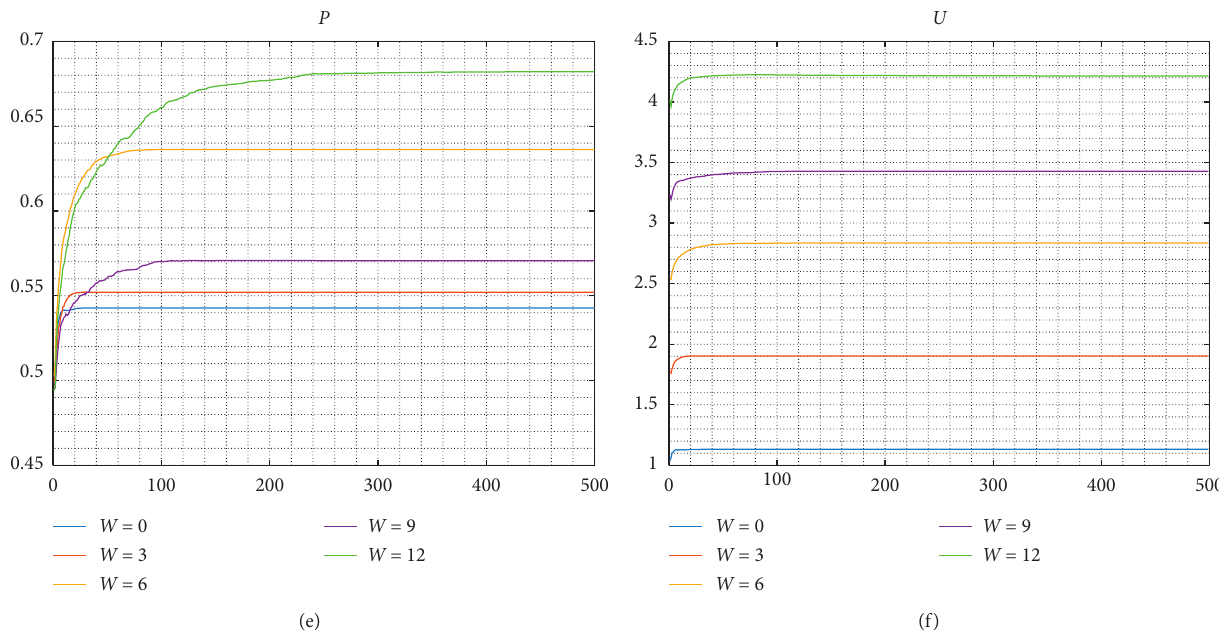
Figure 5: The simulated results of situation 3. (a) P (Case 1). (b) U (Case 1). (c) P (Case 2). (d) U (Case 2). (e) P (Case 3). (f) U (Case 3).